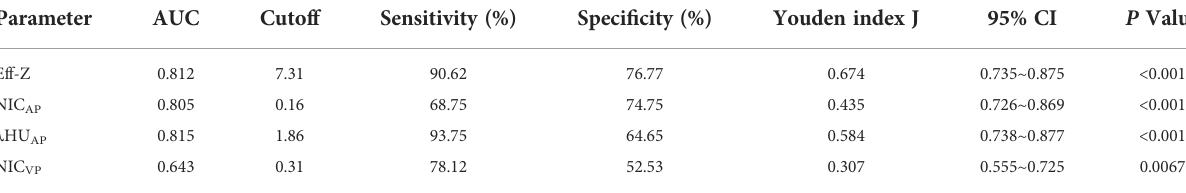
TABLE 5 Performance of DLCT parameters in differentiating high- from low-grade CRAC.